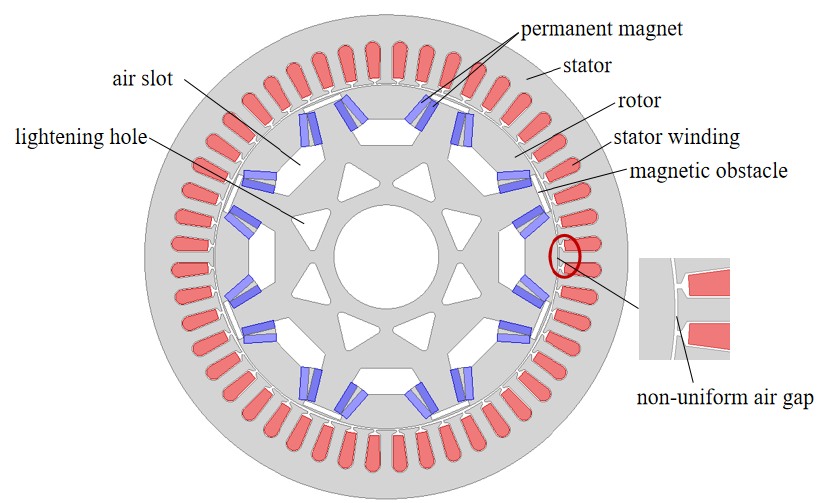
Figure 5. Structure diagram of a single permanent magnet for IPMSMB.